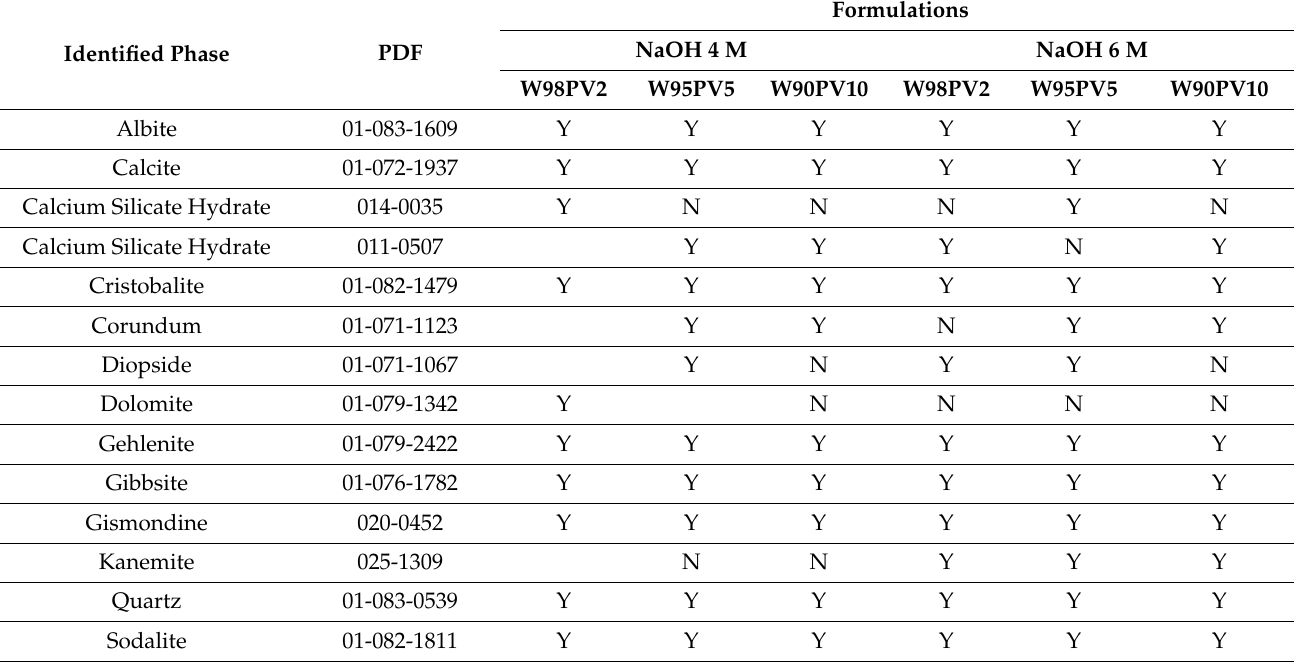
Table 4. Crystalline phases in AA-WBA/PV